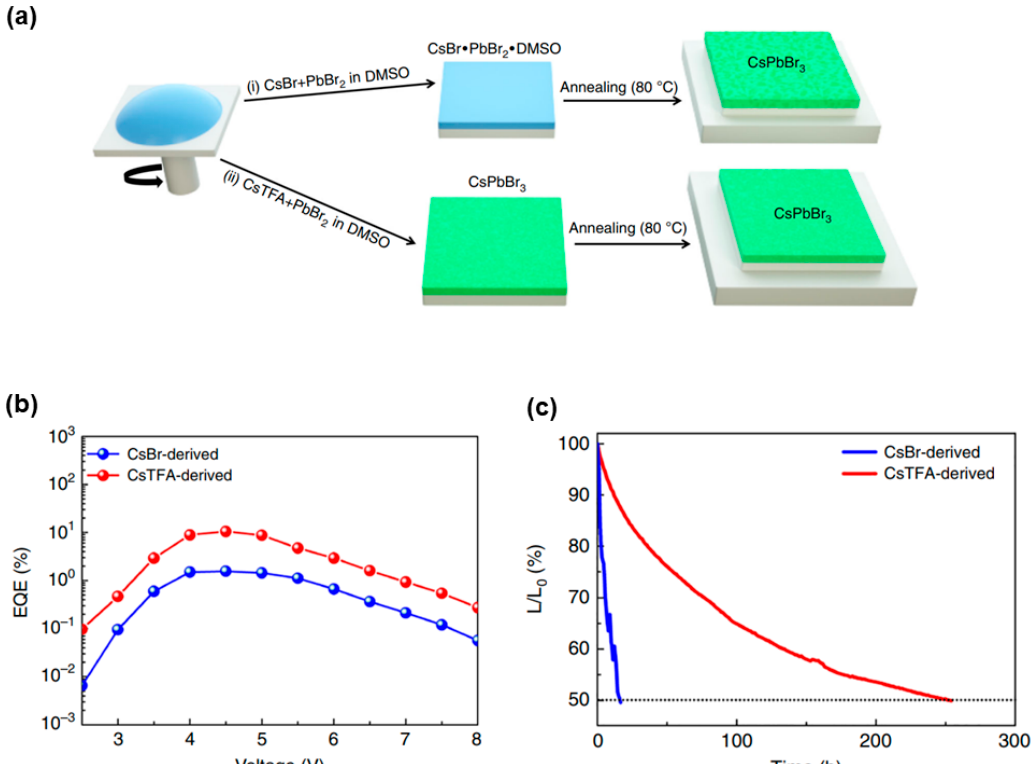
Figure 5. ( a ) Schematic presentation of the film fabrication procedure. Route (i) employed commonly used precursors CsBr and PbBr 2 , while the route (ii) employed CsTFA in place of CsBr. ( b ) EQE of the CsBr- and CsTFA-derived PeLEDs. ( c ) Lifetimes of PeLEDs based on CsBr(1.7)- and CsTFA(1.7)-derived CsPbBr 3 perovskite films. Reproduced from reference [28], Springer Nature, 2019.